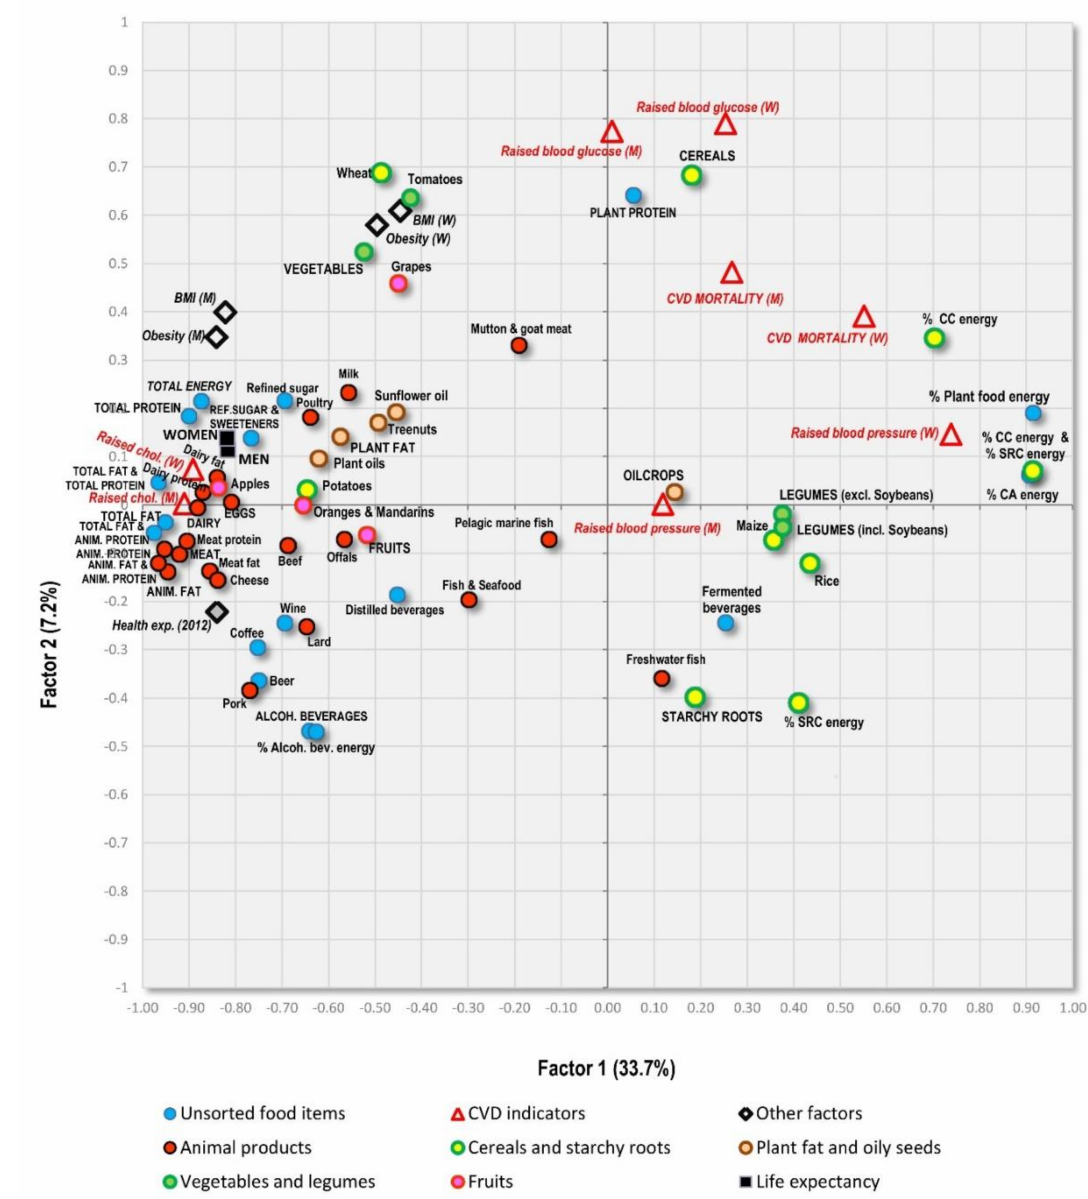
Figure 8. Factor analysis including 75 variables in 158 countries (Factor 1 vs. Factor 2) explaining 40.9% variability; Abbreviations: % CC energy = the mean proportion of carbohydrate energy from cereals; % SRC energy = the mean proportion of carbohydrate energy from starchy roots; % CA energy = the mean proportion of energy from carbohydrates and